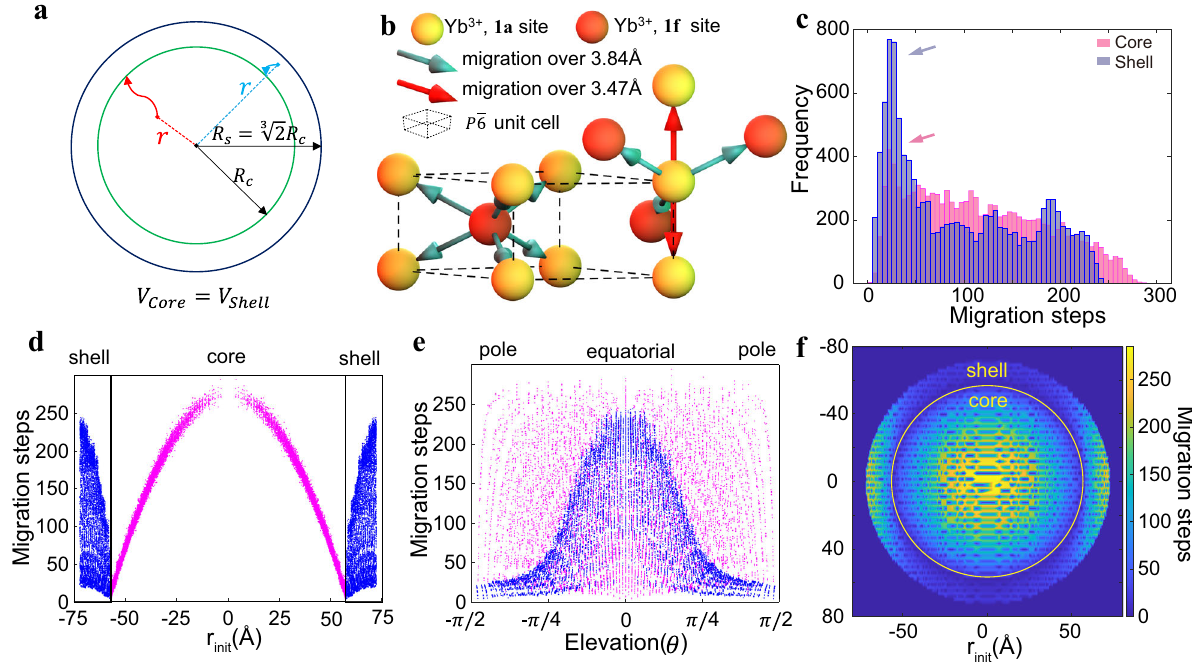
Fig. 4 | Simulation of energy migration from Yb 3+ to interface. a Schematic of interior shell and corresponding radius. b Schematic diagram of NaYbF 4 lattice in P (cid:1) 6 hexagonal space point group. 1a and 1f sites are different types that possess energy migration process and the corresponding energy migration directions. c Frequencyhistogramsofthenumberofmigrationsstepsfromcoreorshelltothe